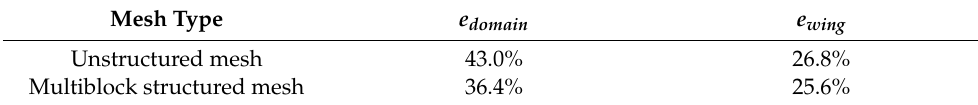
Table 6. Power imbalance error for unstructured mesh and multiblock structured mesh.